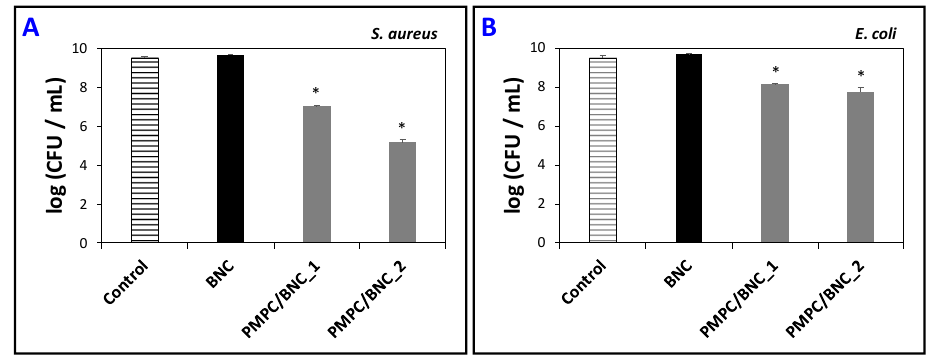
Figure 8. E ff ect of BNC, PMPC / BNC_1 and PMPC / BNC_2 on the bacterial killing (CFU) of ( A ) S. aureus and ( B ) E. coli after 24 h of exposure; error bars represent the standard deviation (three independent experiments); the asterisk (*) denotes statistically significant di ff erences with respect to the control and neat BNC ( p <